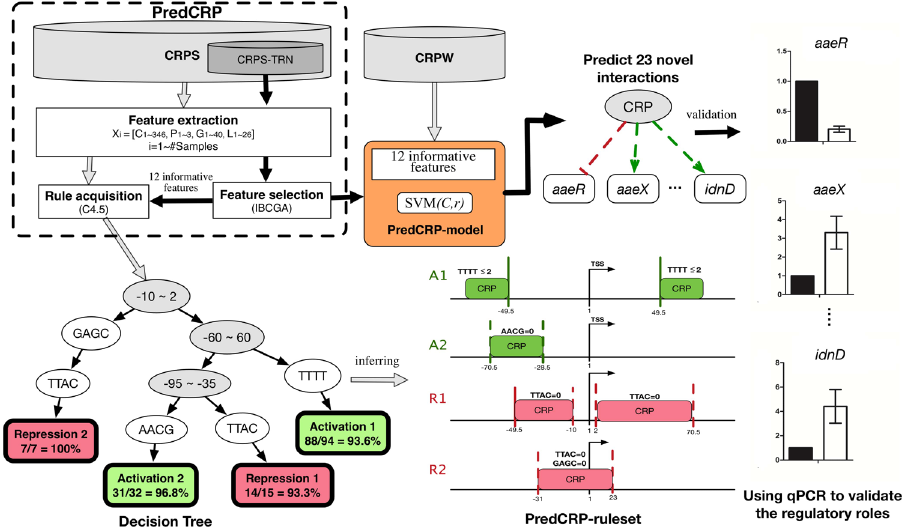
Figure 1. Components for developing and evaluating the proposed PredCRP method. (1) establishment of the CRPS dataset consisting of 169 CRP-binding sites with regulatory roles supported by strong evidence, (2) feature extraction from the training dataset CPRS-TRN, (3) feature selection in cooperation with an SVM, (4) PredCRP-ruleset obtained based on the decision tree method C4.5, (5) PredCRP-model evaluated by CRP-binding sties with weak evidence (the CRPW dataset) and (6) the qPCR experimental validation on the regulatory roles of